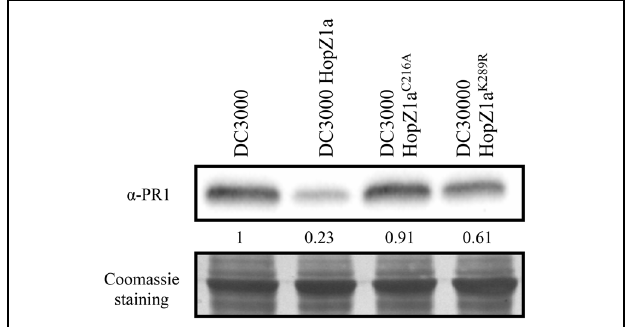
FIGURE 1 | HopZ1a-mediated suppression of local DC3000-triggered PR1 accumulation is reduced but not abolished by the K289R mutation. Western blot showing PR1 accumulation in Col-0 leaves inoculated with 5 × 10 5 cfu/ml of DC3000, DC3000 expressing HopZ1a (pAME30), or DC3000 expressing the mutant derivatives HopZ1a C216A (pAME27) or HopZ1a K289R (pMAM1). Ten micrograms of total protein were loaded per sample, and Coomassie staining is shown as loading control. The signal intensity for each band was quantified using Fiji distribution of ImageJ software and is shown below the blot. The experiment was repeated three times with similar